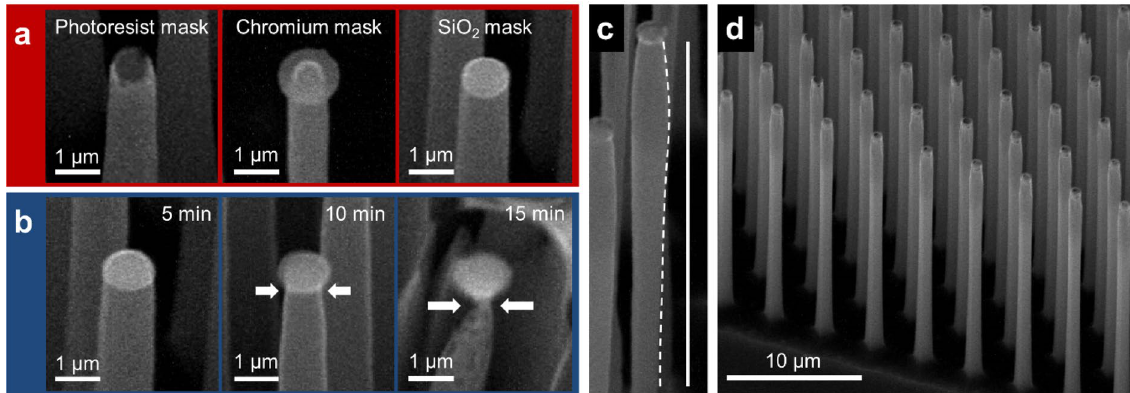
Figure 4. Structural imperfections in high-aspect-ratio Si nanowires affected by different mask materials during ICP-RIE at cryogenic temperature. ( a ) Undercut effects in different mask materials etched using the same etching conditions for 5 min. ( b ) Evolution of undercut in Si nanowires with a SiO 2 mask at etching durations of 5, 10, and 15 min. ( c ) Bowing effect where the diameter of Si nanowire varies with length, forming a larger diameter at the middle compared to upper and lower parts. ( d ) Vertical Si nanowire arrays with an aspect ratio of